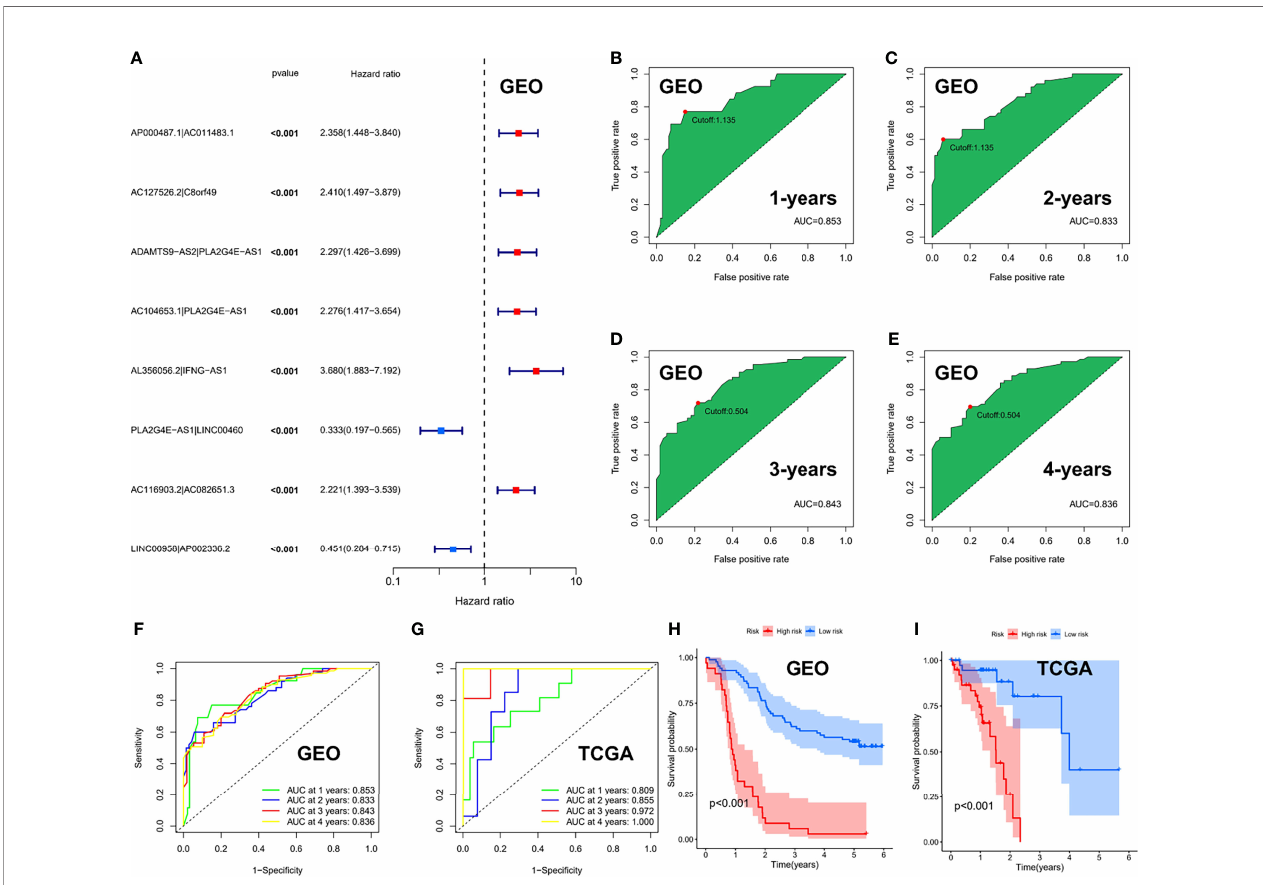
FIGURE 5 | Risk-score model based on ER-lncRNA pairs in ESCC. (A) Forest plot of eight prognostic-related ER-lncRNA pairs through univariate Cox analysis in the GEO cohort. (B-E) The AUC value of the risk score. (F, G) ROC curve analysis of the accuracy of the model to predict patient prognosis at 1, 2, 3, and 4 years in the GEO cohort (F) and the TCGA cohort (G) . (H, I) Kaplan-Meier survival curves for ESCC patients from the GEO and TCGA cohorts, strati fi ed according to cut- off value (high vs.